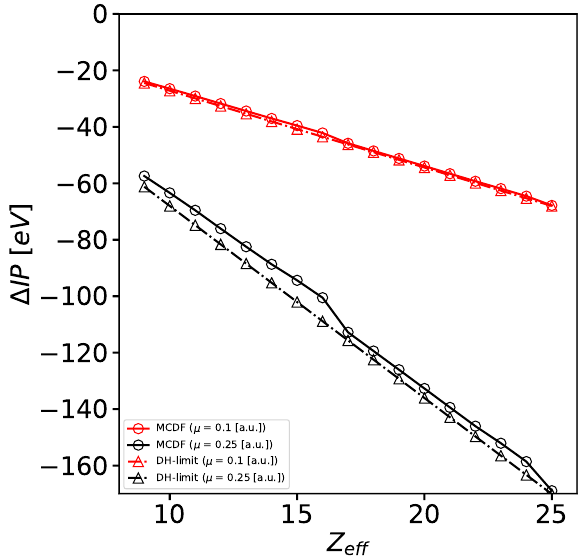
Figure 8. Ionization potential lowering in Fe IX –Fe XXV as a function of effective charge Z eff = Z − N + 1 obtained with the MCDF method using a Debye–Hückel screening potential. Red circles: µ = 0.1 a.u. Black circles: µ = 0.25 a.u. Triangles: Debye–Hückel limit ∆ E DH Figure 1 of [43] with permission from Astronomy & Astrophysics,